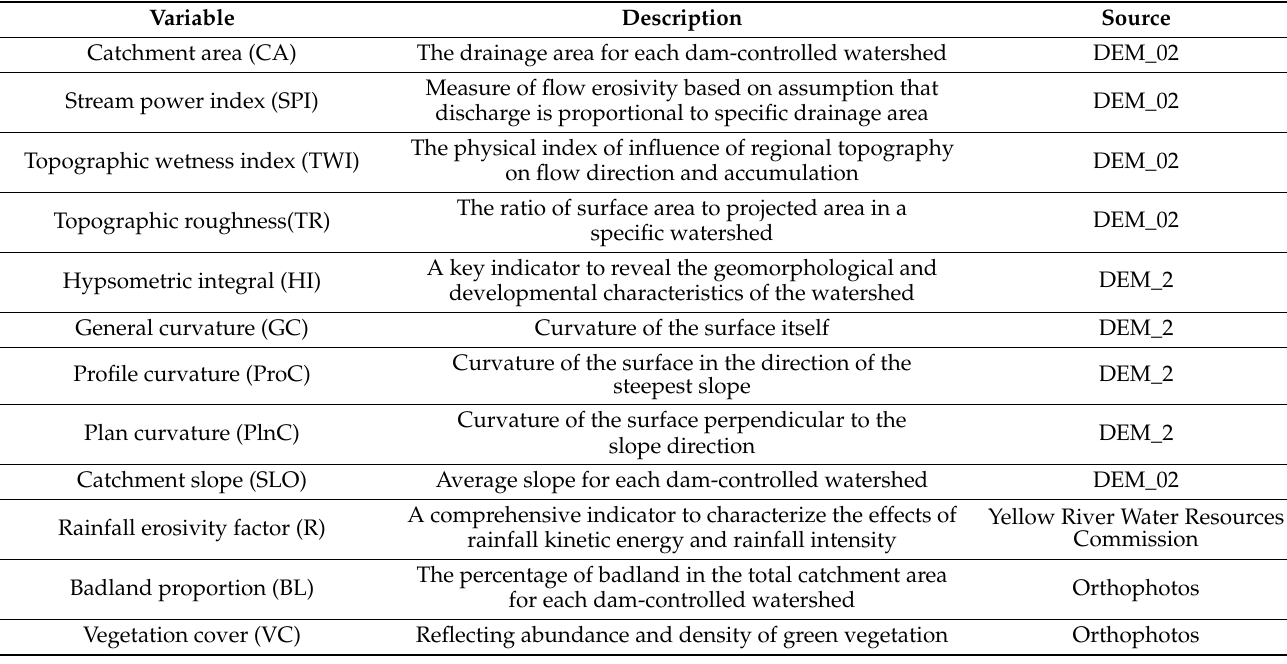
Table 4. Environmental variables used for the regression analysis.